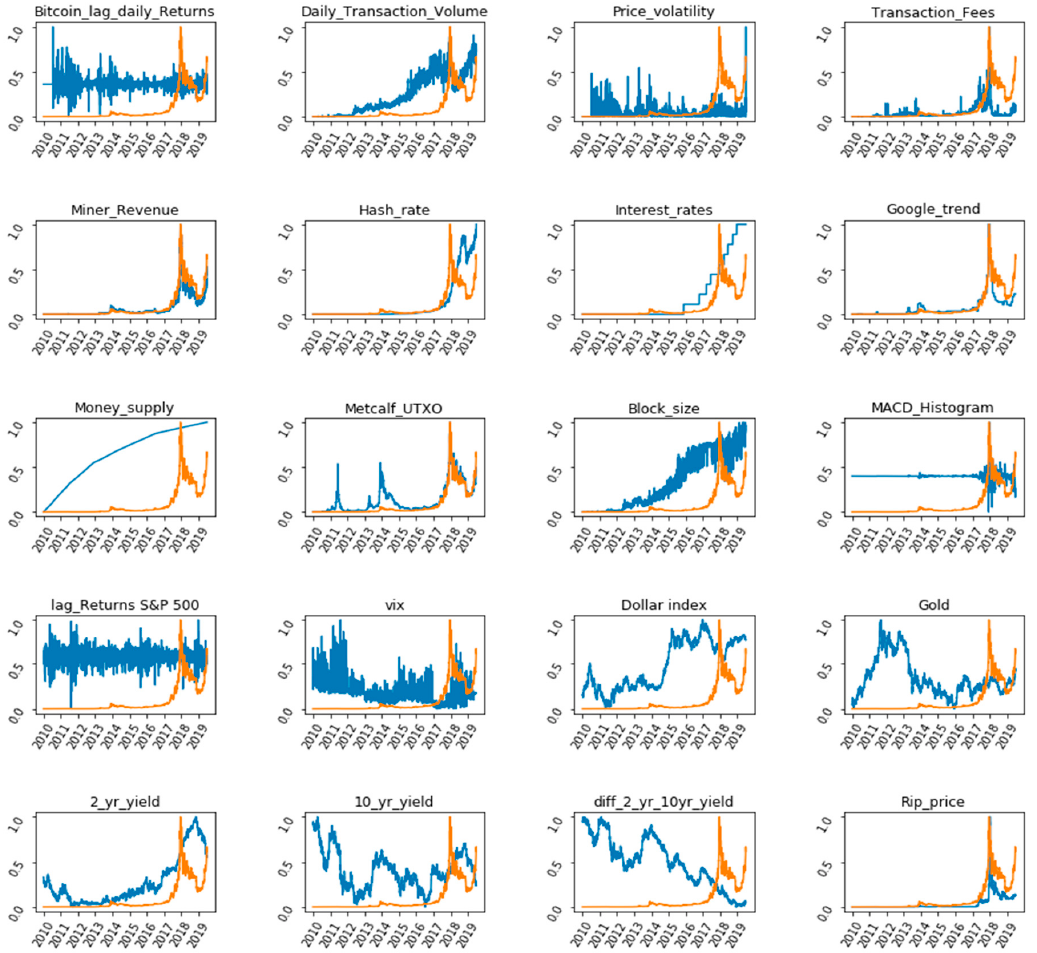
Figure 4. Plot showing the behavior of independent variables with Bitcoin price. The blue line plots the different features used for Bitcoin price prediction and the orange line plots the Bitcoin price over time. Abbreviations: MACD, Moving average convergence divergence.